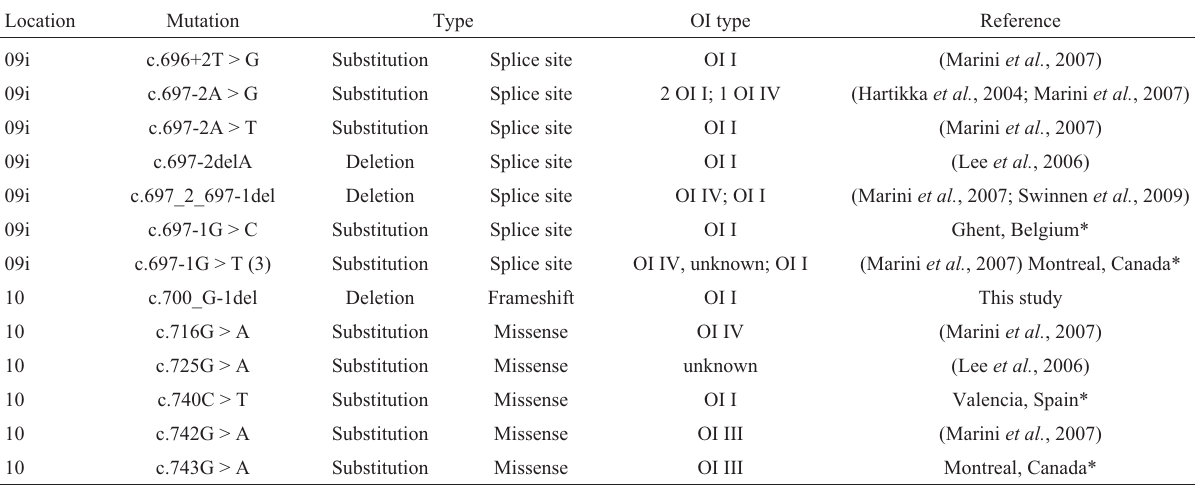
Table 1 - Comparison of OI types with a mutation in the ninth intron or the tenth exon of COL1A1 .